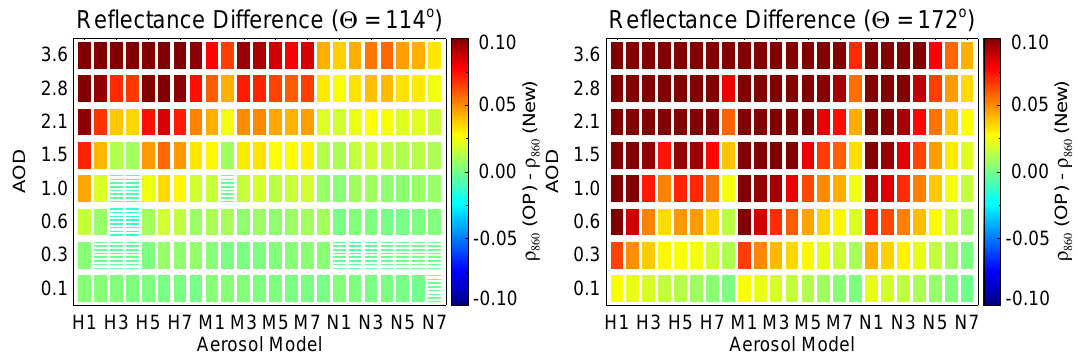
Fig. 4. TOA reflectance difference at 860 nm between MODIS aerosol models and new aerosol models with respect to AOD for a given geometry. SZA ( θ o ) and SAZA ( θ s ) are assumed to be 50 ◦ for both tests and RAA ( φ) is assumed to be 90 ◦ (left) and 170 ◦ (right), resulting in scattering angle ( 2) of 114 ◦ and 172 ◦ , respectively. Corresponding MODIS aerosol models to the new aerosol models are created by combining F2 (“Water Soluble”) and C8 (“Dust-like type”) aerosol models from Remer et al. (2006) for SSA < 0.95 and F4 (“Water Solublt with humidity”) and C8 for SSA > 0.95 using FMF values from new aerosol models. Negative values are shown in